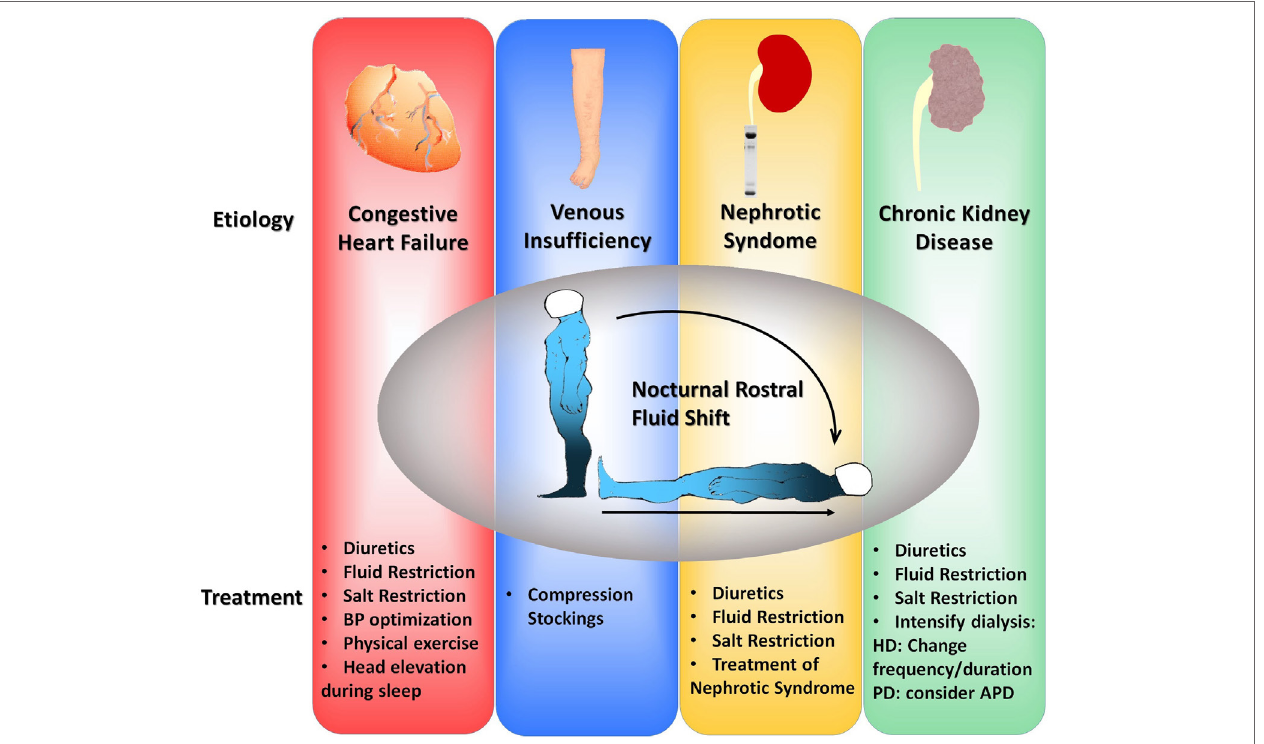
TAble 2 | Studies that evaluated the impact of target therapies on SA in patients with fluid overload conditions. Study Condition Population Targeted Therapy Findings Bucca et al. (69) Diastolic HF 15 patients with severe OSA Furosemide + Spironolactone for 3 days AHI reduced from 74.89 ± 6.98 to 57.17 ± 5.40 events/h, associated with reduced body weight, improvement of or pharyngeal junction area and respiratory flow Yamamoto CHF 10 patients included in cardiac Aerobic exercise training for 6 months AHI remained stable in control group after 6 months, et al. (70) rehabilitation program vs. 8 from 30.4 (19.9; 36.3) to 36.6 (8.6; 39.4) and control patients